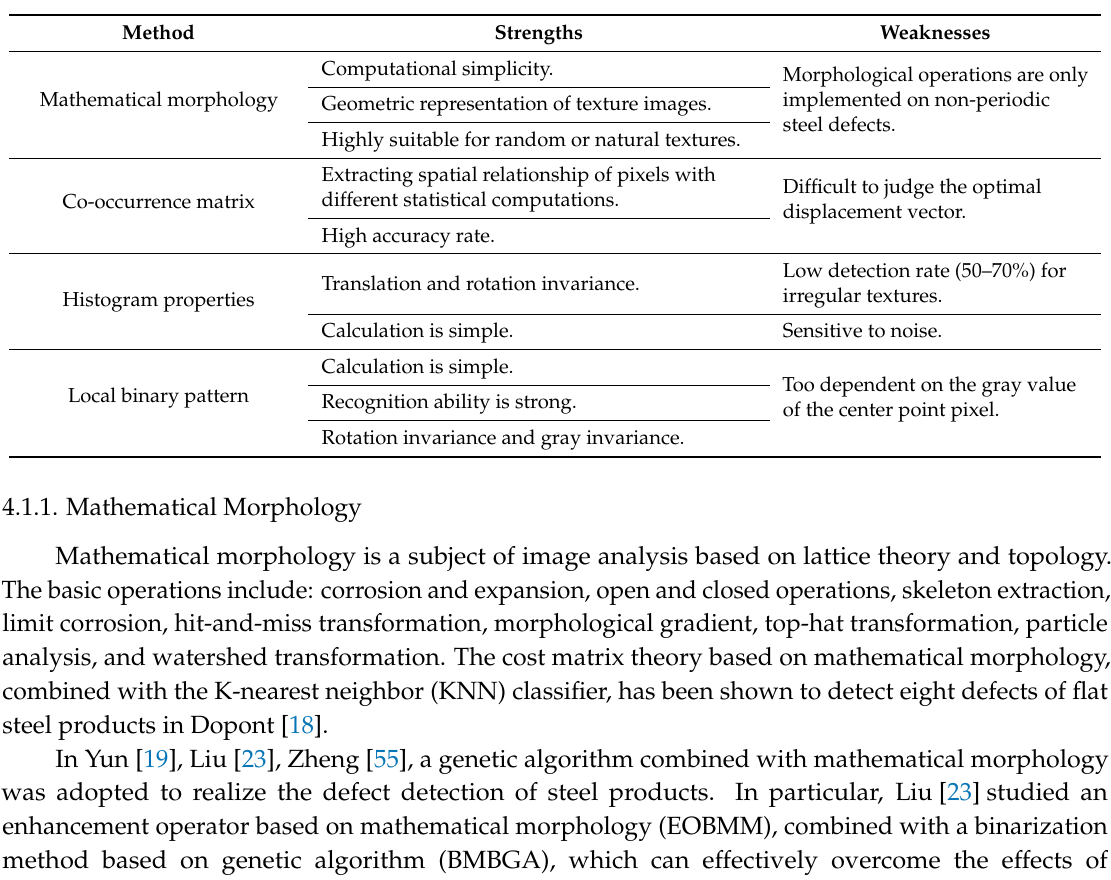
Table 2. Strengths and weaknesses of statistical detection methods for steel